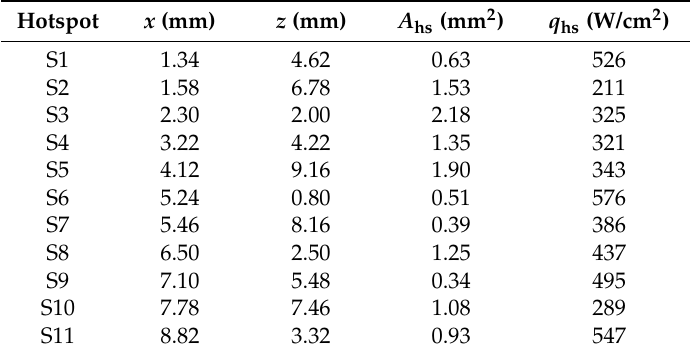
Table 4. Hotspots for the HS2 scheme.